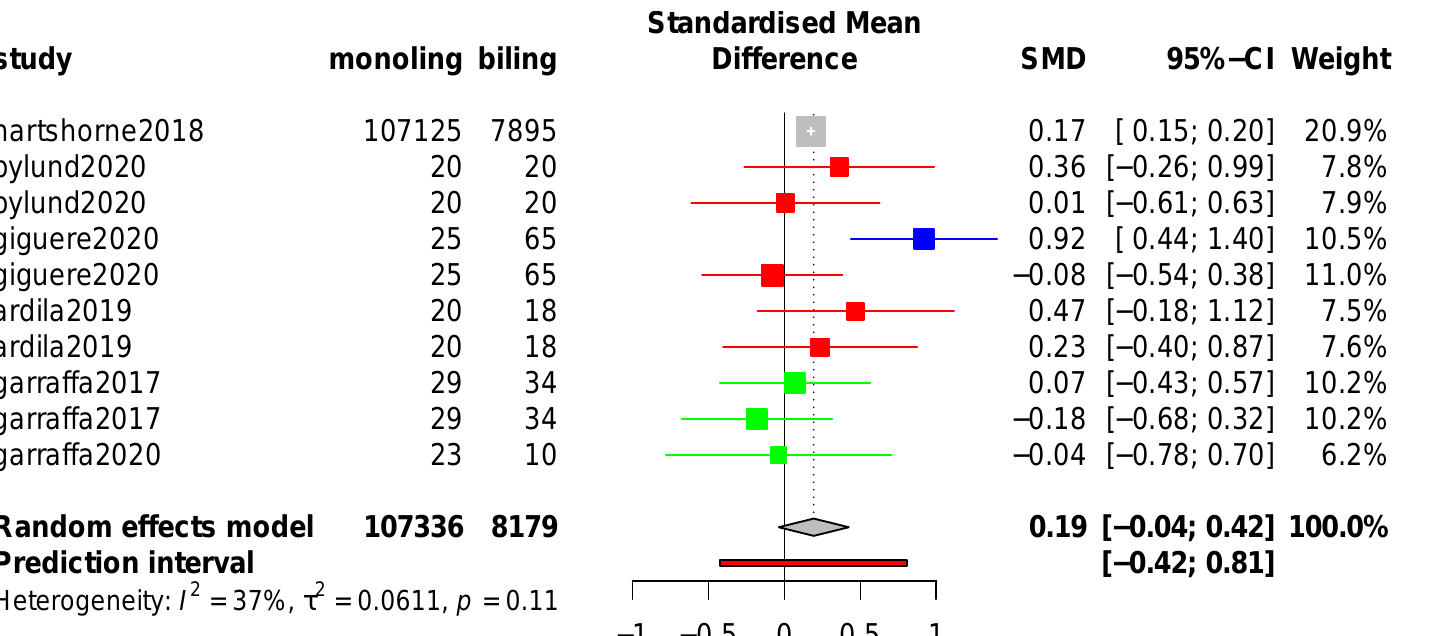
Figure 1. Meta-analysis forest plot. Red : heritage bilingual (at least one parent speaks ‘foreign’ language), tested in majority language. Blue : heritage bilingual, tested in heritage language. Green : minority language (member of non-immigrant minority language group), tested in majority language. Grey : mixed (subjects involve some mix of the other categories) (Ardila et al. 2019; Bylund et al. 2020; Giguere and Hoff 2020; Hartshorne et al. 2018; Garraffa et al. 2017,